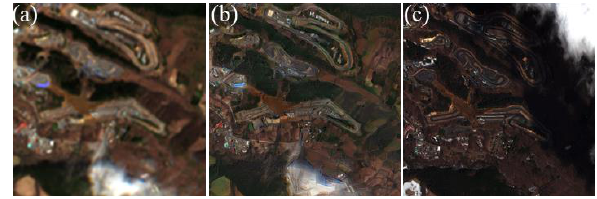
Figure 13. Test results of EXP2 for Nihonmatsu image (a) LR S2 image (10.0 m) (b) Output (2.5m) (c) Ground truth image (2.5m).